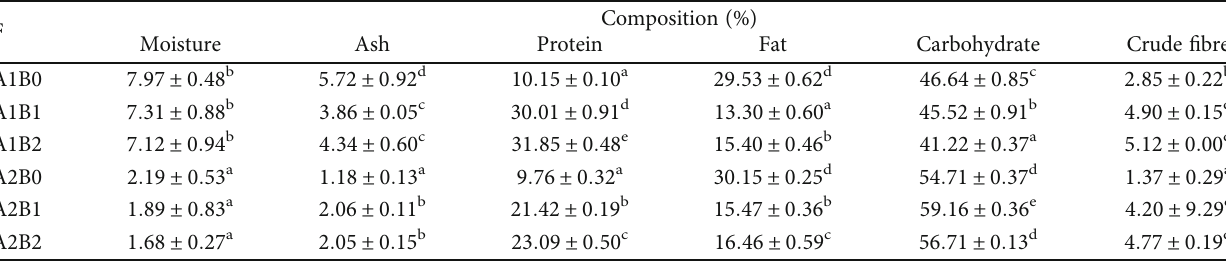
Table 4: Proximate nutrient content of cream soup formulas.